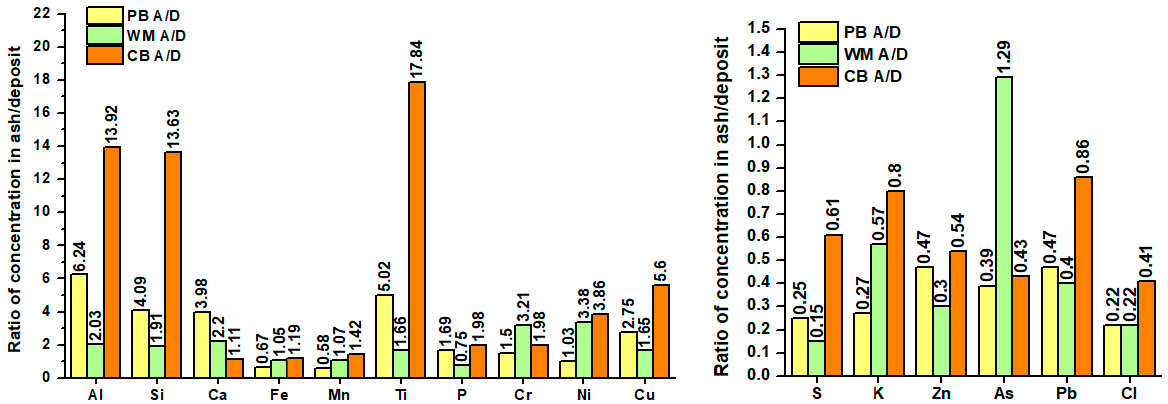
Figure 10. Ratios of concentrations of elements in ash/deposits (A/D) calculated from arithmetic mean values.